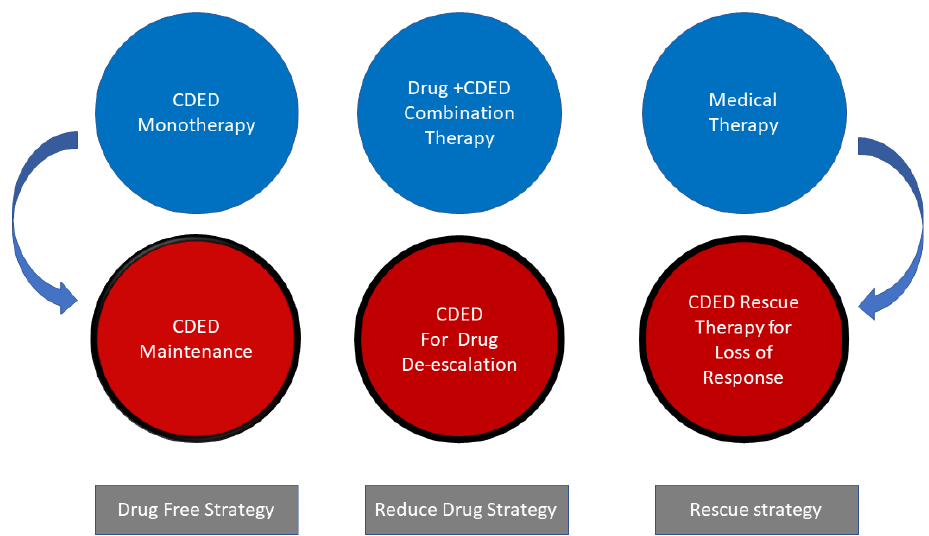
Figure 1. New potential strategies incorporating dietary therapy in Crohn’s disease. CDED: Crohn’s disease exclusion diet